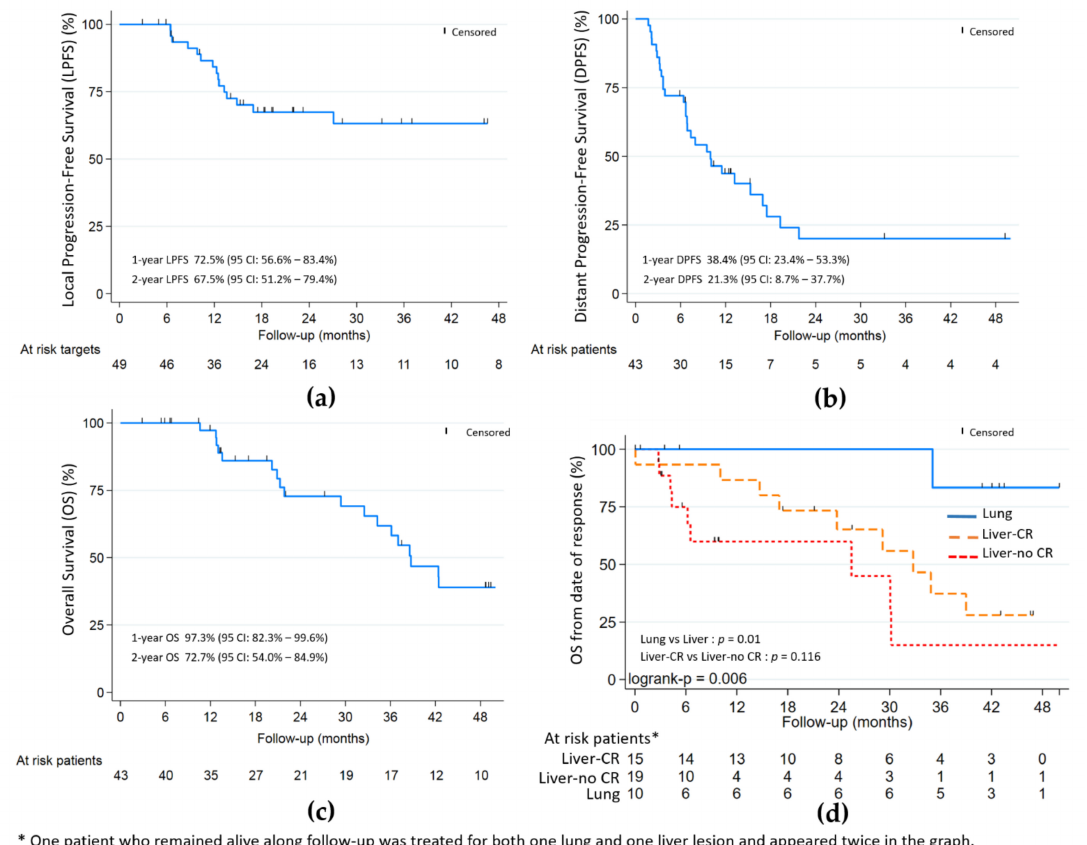
Figure 2. ( a ) Local progression-free (LPFS); ( b ) distant progression-free (DPFS); and ( c ) overall survival (OS). ( d ) OS by lung and liver with and without complete response (CR). Median follow-up of 48.9 months. Lung metastases were not significantly associated with better LPFS (HR 0.26, p = 0.199) or PFS (HR 0.51, p = 0.177), but with better OS (HR 0.10, p = 0.01) (Figures 2 and 3). Patients in the lung subgroup had smaller lesions compared to liver subgroup (median PTV volume = 15.2 cm 3 versus 45.9 cm 3 , p = 0.002 and median largest axis = 13 mm versus 30 mm, p = 0.002). A higher proportion of synchronous metastatic patients was also seen in the liver subgroup: 21/34 (61.7%) versus 2/10 (20%) ( p = 0.031).